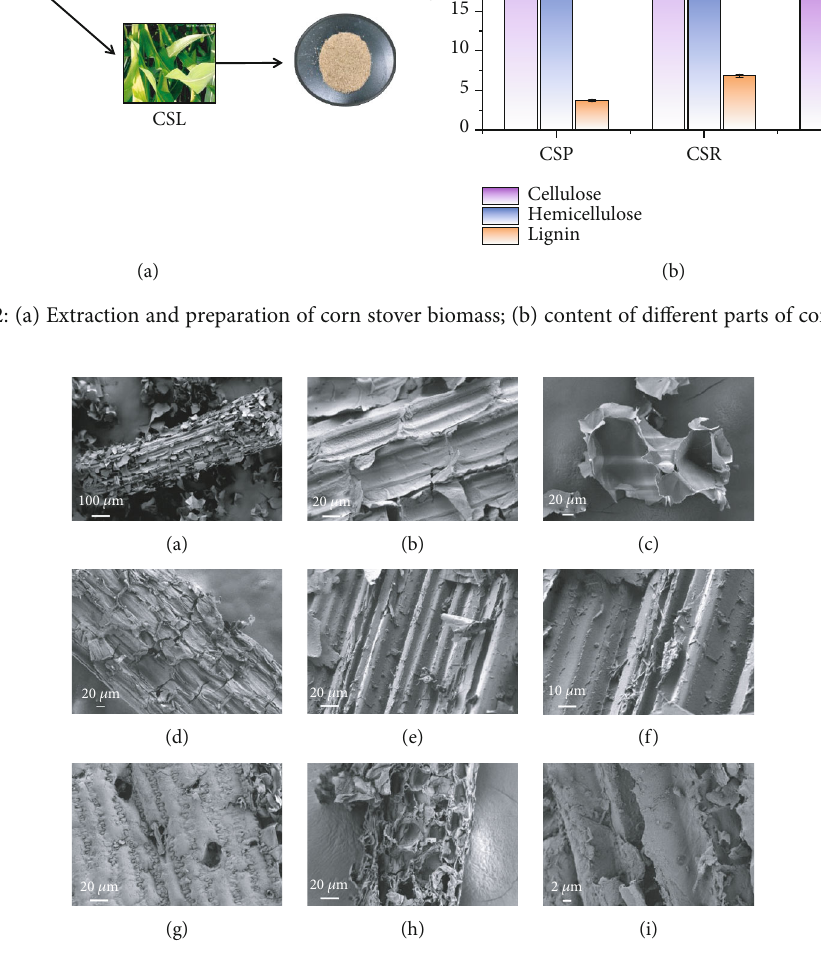
Figure 3: SEM photographs of corn stover pith (a – c), rind (d – f), and leaf (g – i) at di ff erent magni fi cations.